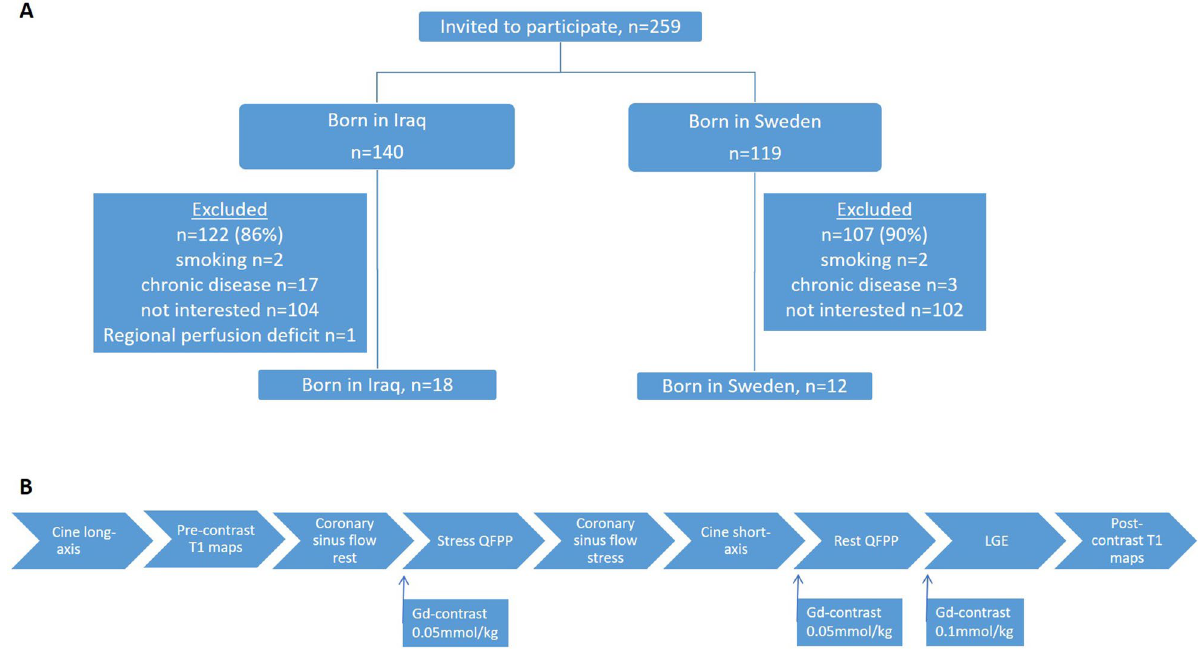
Figure 1. ( A ) Schematic flowchart for eligible participants, all males, performing a cardiovascular magnetic resonance study. ( B ) CMR scan protocol timeline with timings for gadolinium contrast